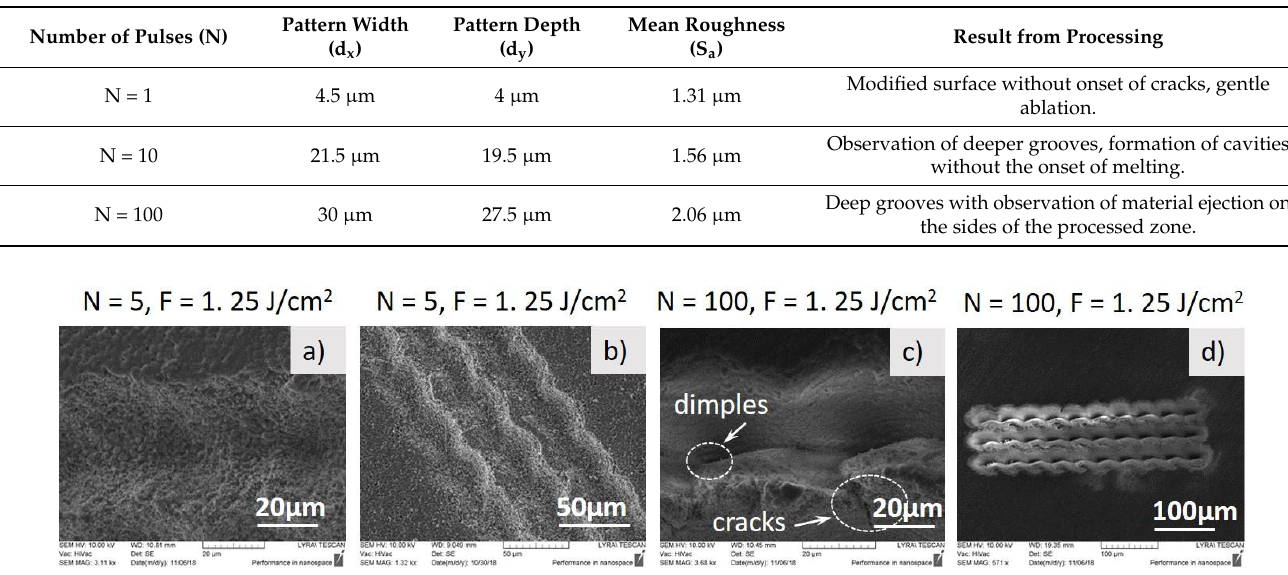
Figure 3. SEM images of surface-modified β -TCP pellets in the form of microchannels formed after laser irradiation in spot-to-spot scanning regime with fs-laser pulses for the following: N = 5 ( a , b ) and 100 ( c , d ); F = 1.25 J/cm 2 , λ = 800 nm, τ = 130 fs.